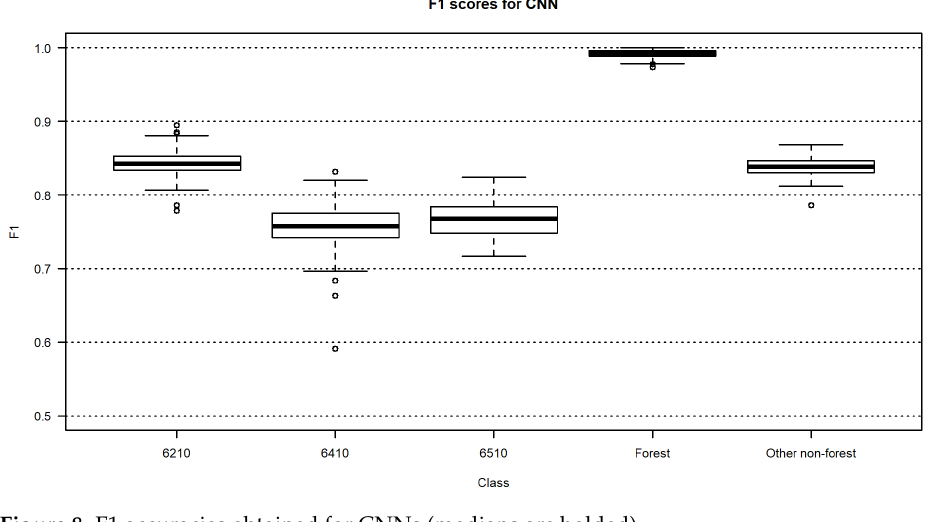
Figure 7. Overall accuracies obtained for three algorithms (medians are bolded).